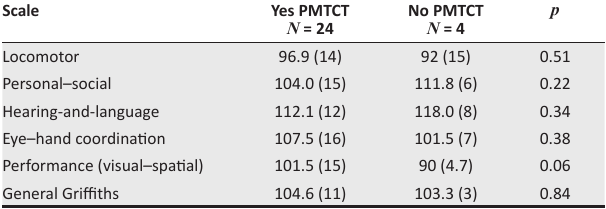
TABLE 1-A1: Comparison of Griffiths mental development scales quotients in those whose mothers had antiretroviral therapy for prevention of mother-to-child transmission of HIV or not reported as mean (standard deviation).